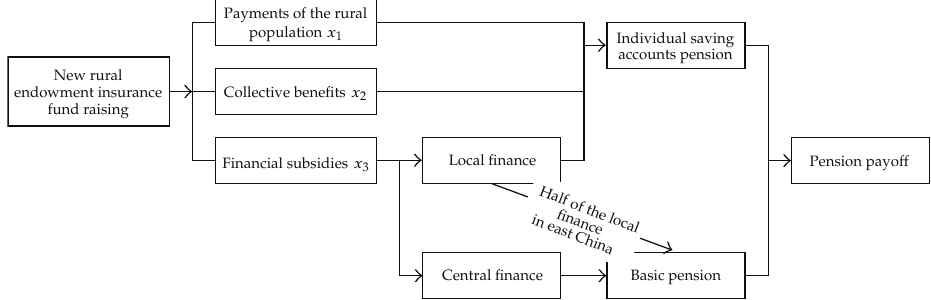
Figure 1: Incomings and outgoings of new-type rural social endowment insurance